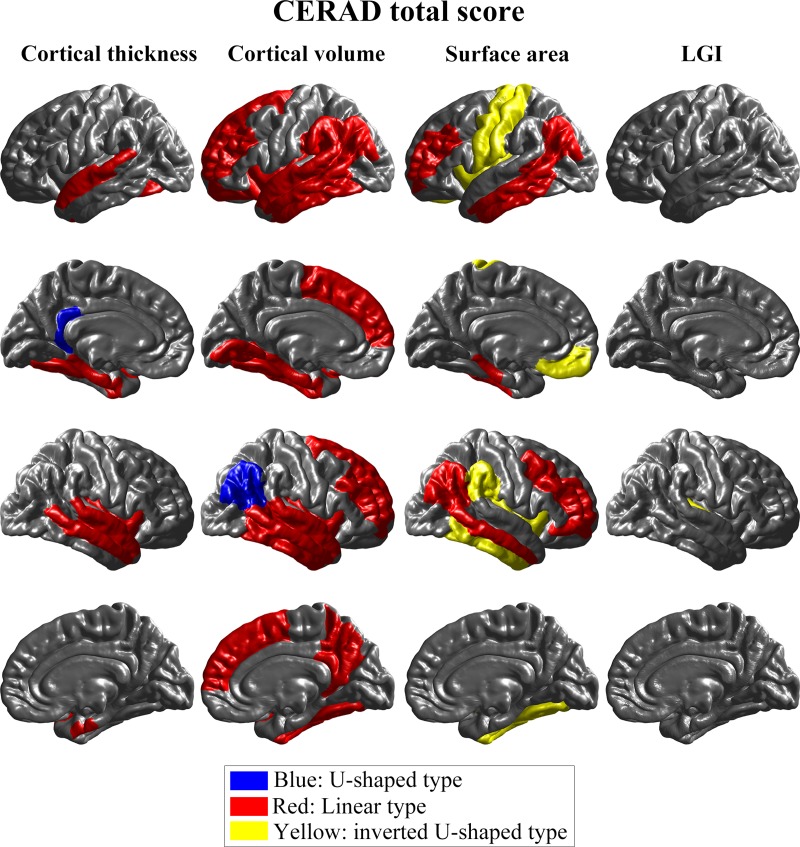
Comparison of descending graph types between cortical volume, thickness, surface area, and LGI in CERAD total score.The first and second rows show the left hemisphere from a lateral and medial view, respectively. Similarly, the third and fourth rows represent the right hemisphere from a lateral and medial view. The blue regions represent the U-shaped type and indicate sensitivity to cognitive impairment in the early stages of the Alzheimer disease. The red regions represent the linear type, showing that the ROI may be continuously damaged as the disease progresses. The yellow regions represent the inverted U-shaped type, meaning that cognitive decline is especially sensitive at the last stages. LGI local gyrification index.